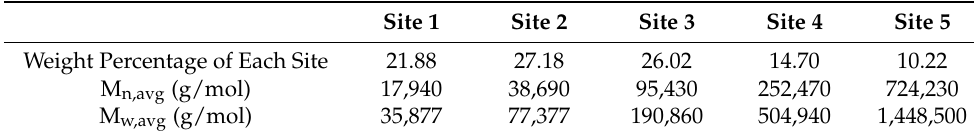
Table 2. Molecular Weight Distribution Deconvolution